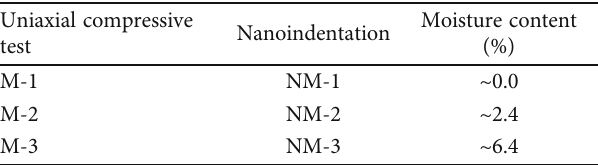
Table 1: Experimental